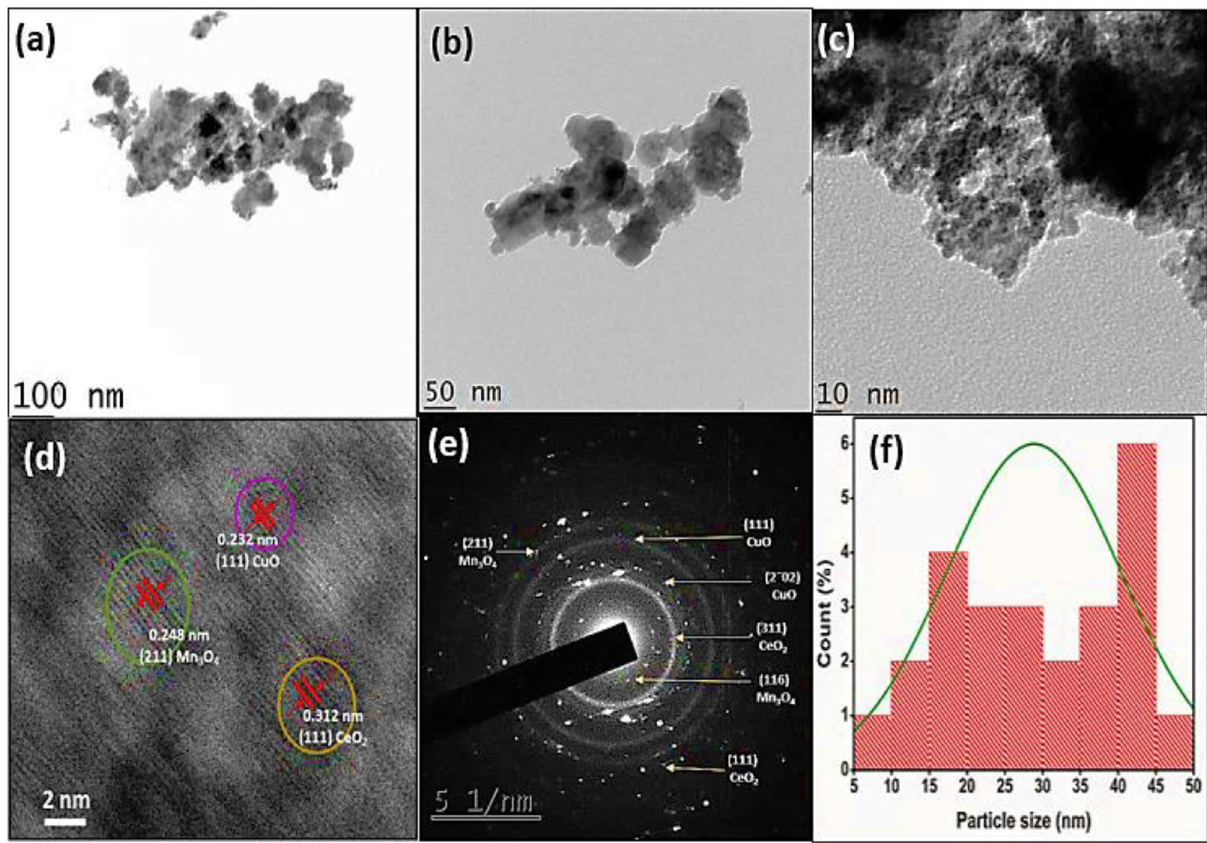
Figure 4. ( a – c ) TEM images of CMCu heterostructure at ( a ) 100 nm, ( b ) 50 nm, ( c )10 nm, ( d ) HRTEM image of CMCu heterostructure at 2 nm, ( e ) SAED pattern of CMCu heterostructure, and ( f ) histogram of CMCu heterostructure for average particle size